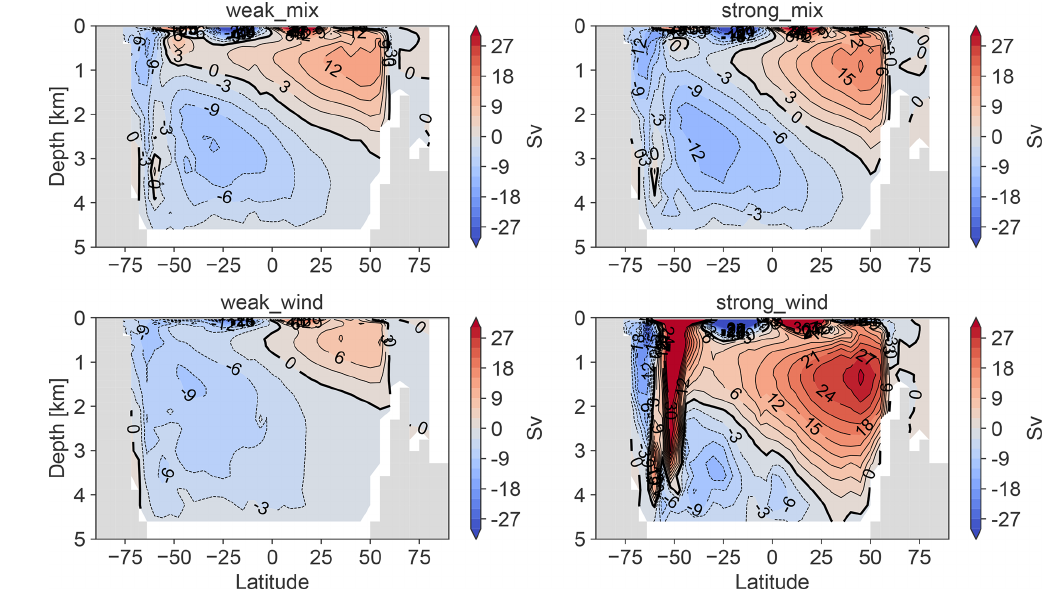
Figure A5. Global overturning circulation in a steady state (15-year average) for sensitivity simulations (see Fig. 3c for the standard simu- lations). The overturning stream function is positive (red) for water rotating clockwise and negative (blue) for water rotating